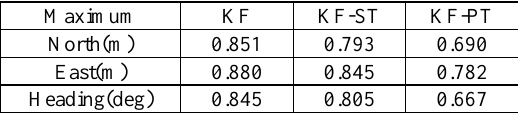
Table 2. Maximum Absolute Position and Heading Errors